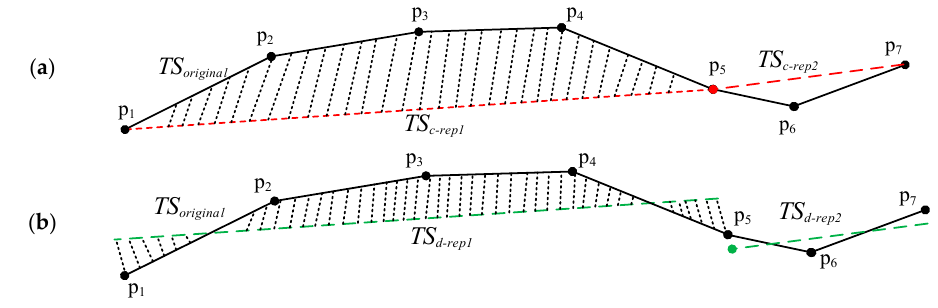
Figure 2. Illustration of the continuous representative segments and the discrete representative segments. ( a ) The continuous trajectory segments; and ( b ) The discrete trajectory segments.